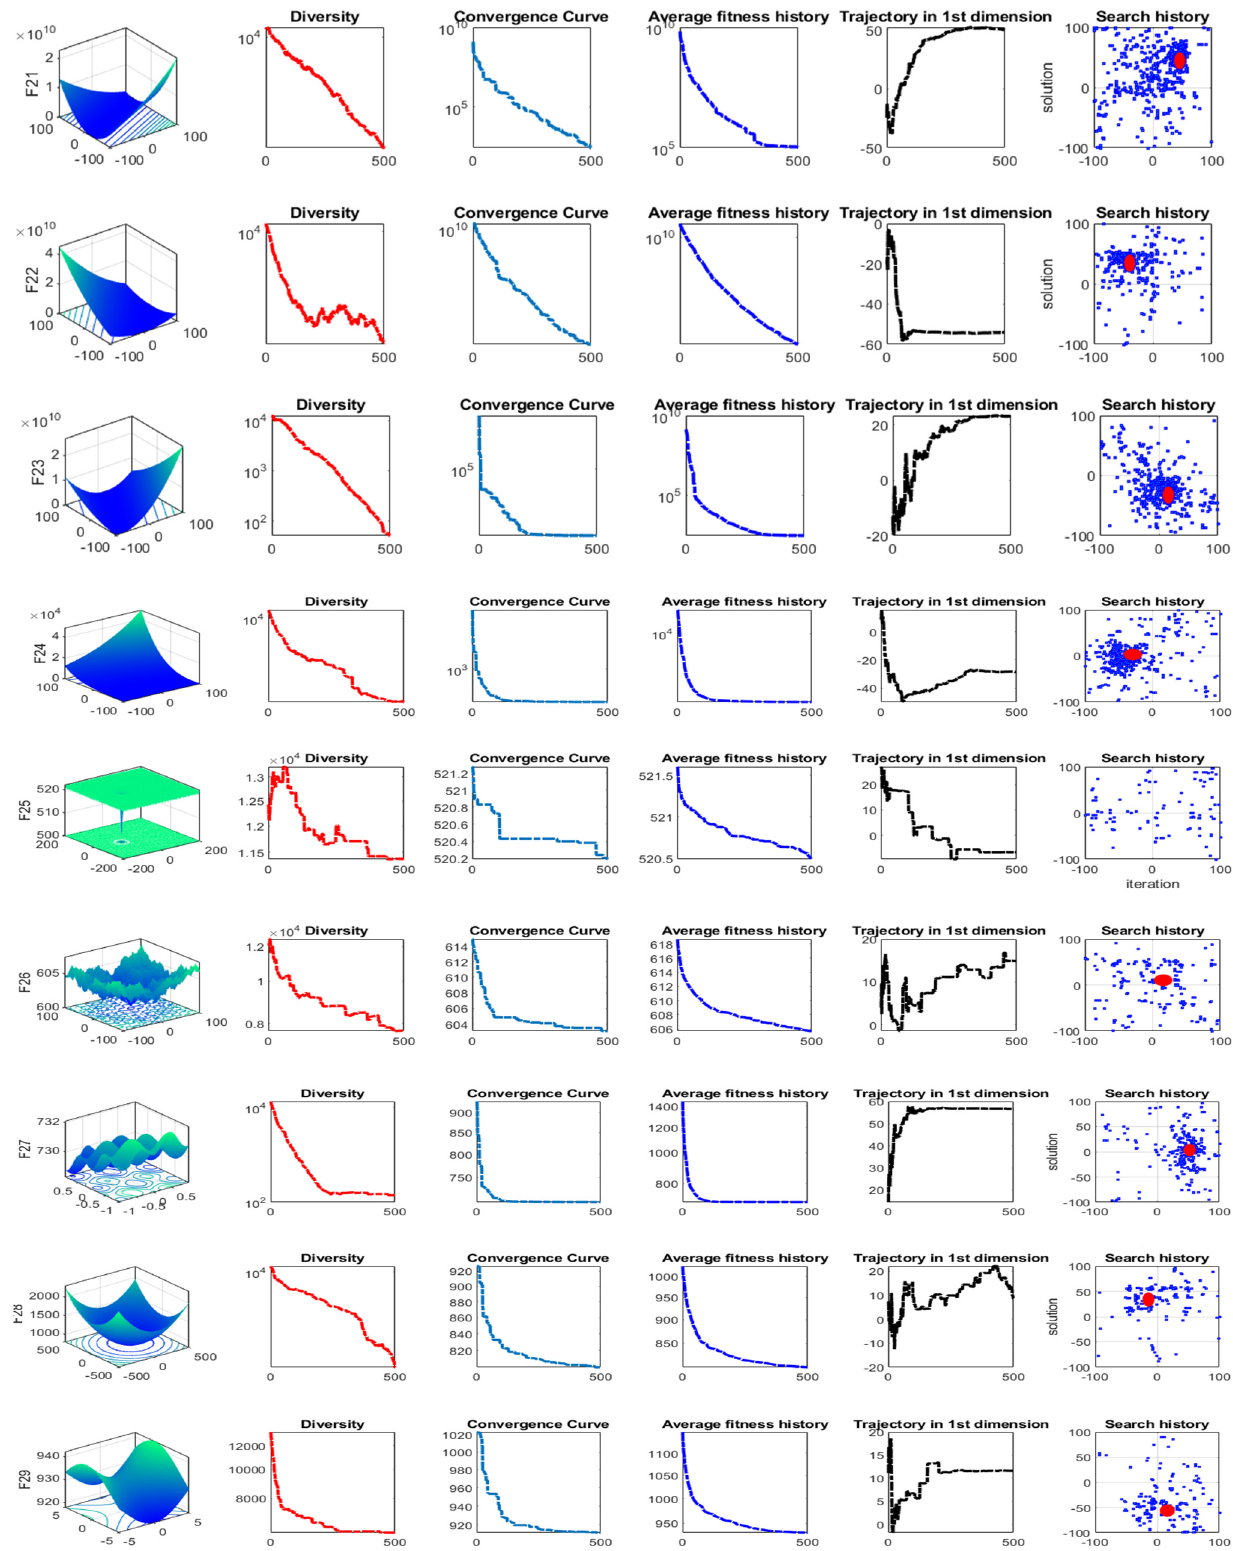
Figure 18. Diversity, convergence curve, average fitness history, trajectory, and search history.